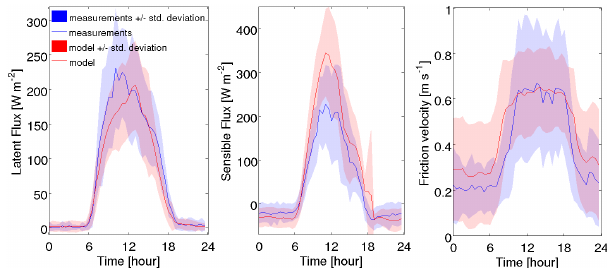
Figure 3. Averaged modeled and measured diurnal cycles of la- tent heat flux (left), sensible heat flux (middle) and friction veloc- ity (right). Measurement average (line) and ± 1 standard deviation (shaded area) are in blue; model average (line) and ± 1 standard de- viation (shaded area) are in red. The comparison is made above the canopy at 30m. Figure 4. Averaged modeled and measured diurnal cycles of MBO